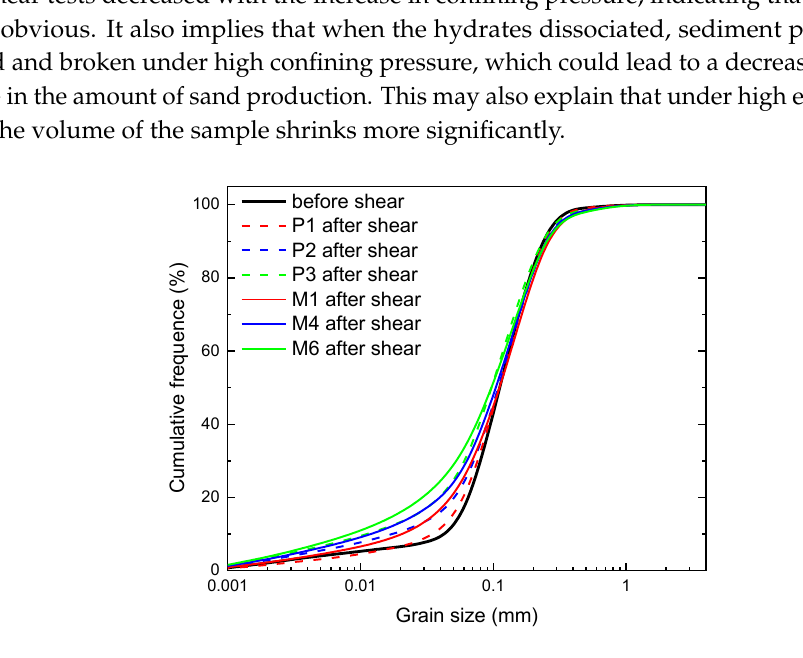
Figure 8. Particle size distributions of sediments before and after shear. Table 2. Median size of the specimens after the shear tests.